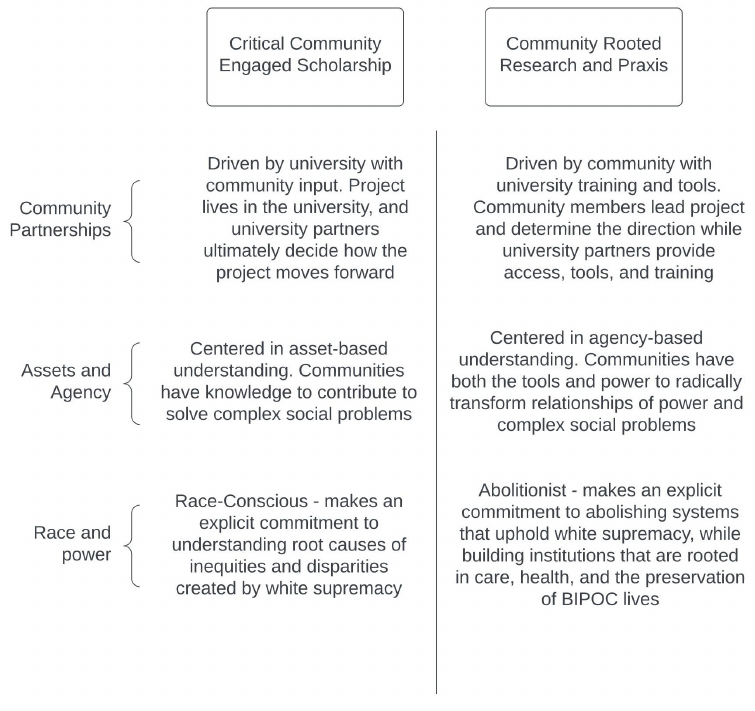
Figure 1. Difference between CCES and CRRP.